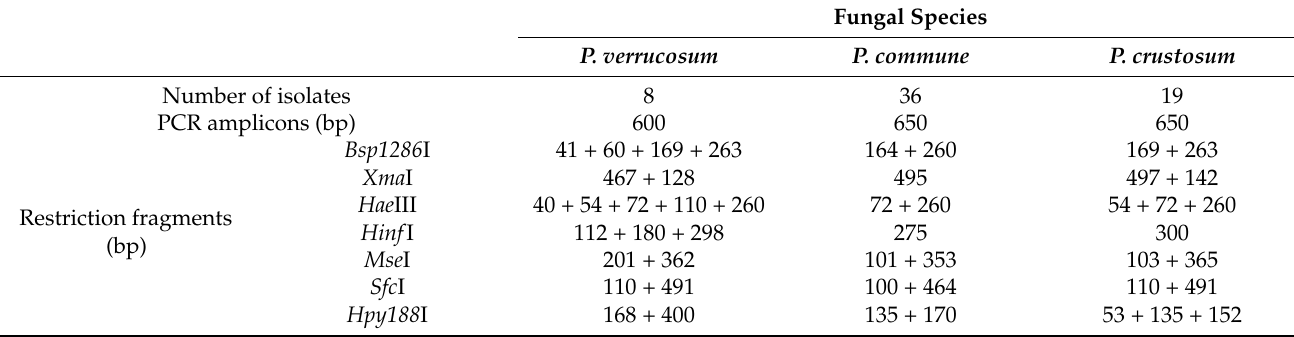
Table 3. Species-specific identification of Penicillium species based on ribosomal restriction patterns.